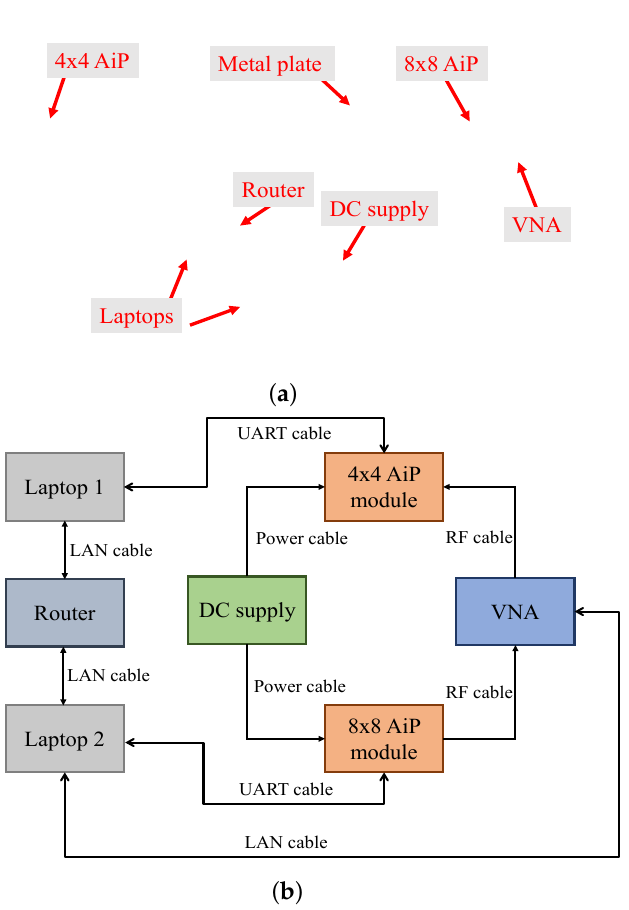
Figure 12. ( a ) Photograph and ( b ) block diagram of the AiPs channel sounder setup.